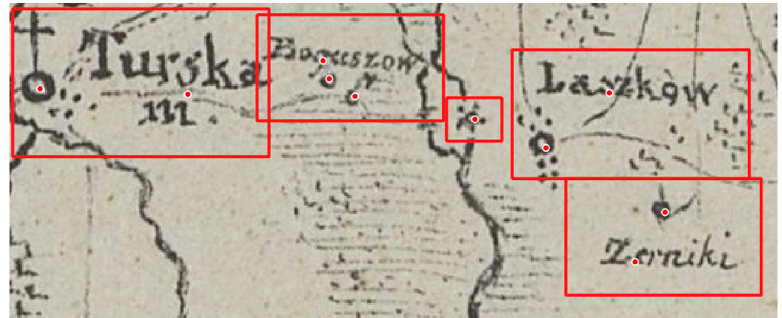
Figure 3. Fragment of the ‘special map’ of Kalisz palatinate depicting the complexity of the drawing. Going from the left, there is “Turska m.” which is a parochial village (proper name and sign are overlapped by the red polygon), then there is “Boguszow” village with an inn (proper name and two signs are overlapped), a separate mill and two other villages. The polygons are features is the database as allow for flexible linking between sometimes ambiguously represented annotations and